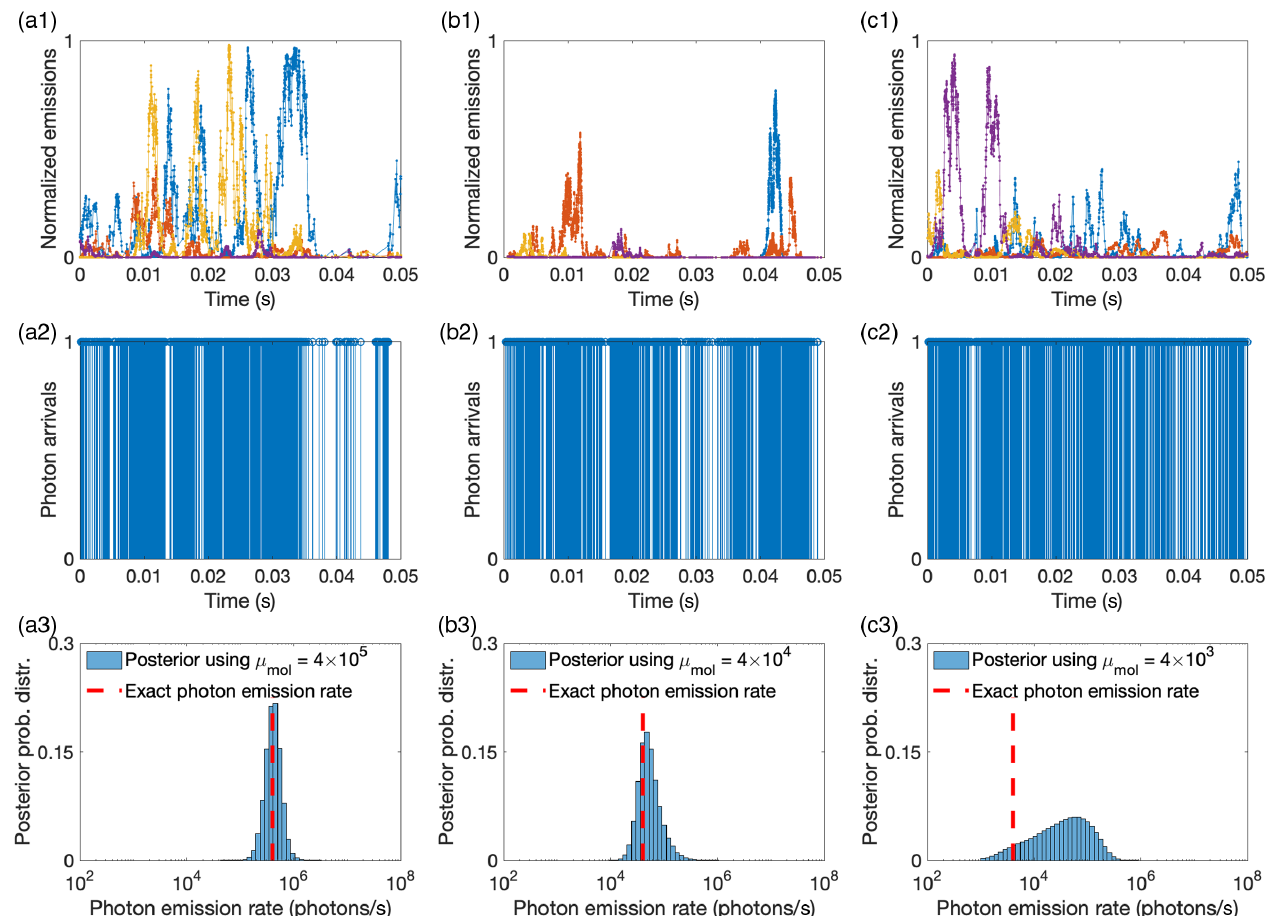
FIG. 17. A higher molecule photon emission rate provides more photons per unit time and sharper emission rate estimates. (a1),(b1),(c1) Instantaneous molecule photon emission rates μ n , normalized by μ . (a2),(b2),(c2) Photon arrival traces resulting from mol k combining photon emissions from every molecule and the background. These traces produced by 10 molecules diffusing at 10 μ m 2 = s for a total time of 50 ms under a background photon emission rate of 10 3 photons = s and molecule photon emission rate 4 × 10 5 photons = s containing ≈ 3000 photon arrivals (a2), molecule photon emission rate 4 × 10 4 photons = s containing ≈ 2000 photon arrivals (b2), and molecule photon emission rate 4 × 10 3 photons = s containing ≈ 1000 photon arrivals (c2). (a3), (b3),(c3) Posterior probability distributions drawn from traces with differing molecule photon emission rates [shown in (a2),(b2),(c2)]. As expected, for the traces with a higher molecule photon emission rate, the peak of the posterior sharply matches with the exact value of μ (dashed line). Gradually, as we decrease the molecule photon emission rate, the estimation becomes less mol